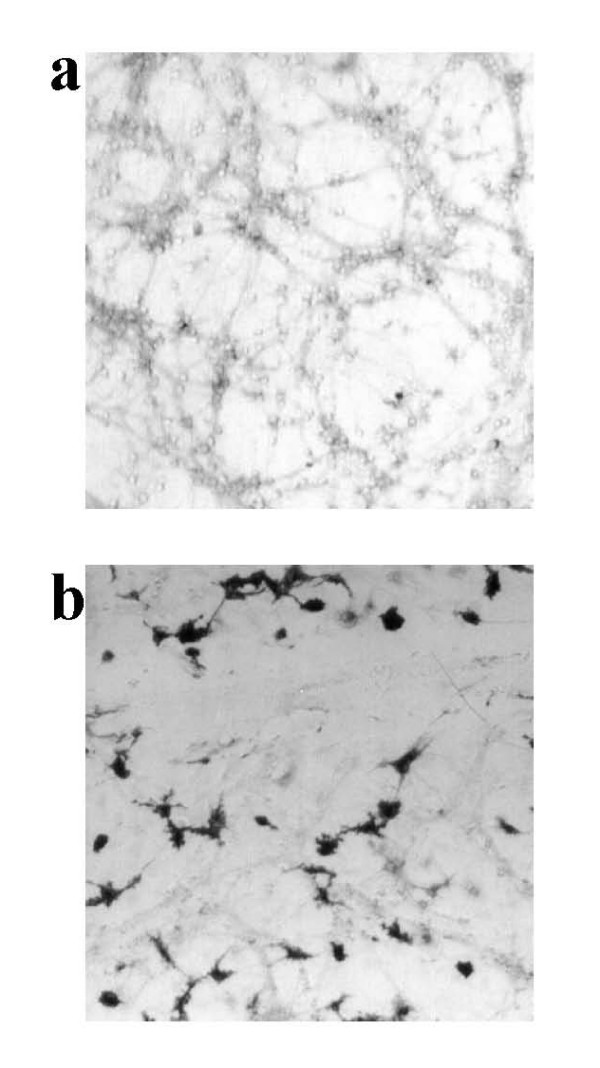
NOS activity in mature neuronal-glial cultures. NADPH diaphorase staining was used to assess for NOS activity. Non-activated (control) cultures show weak staining in neurons and along their processes (a), but following LPS/IFN-γ treatment (b) dark staining is visible in glia (astrocytes and microglia). The photographs shown are representative and were taken 48 hours after treatment, n>3.